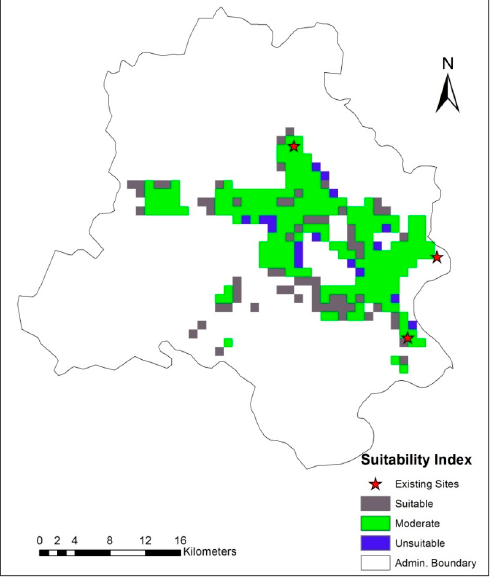
Figure 5. Final suitability map for landfill site with existing landfills in Delhi.